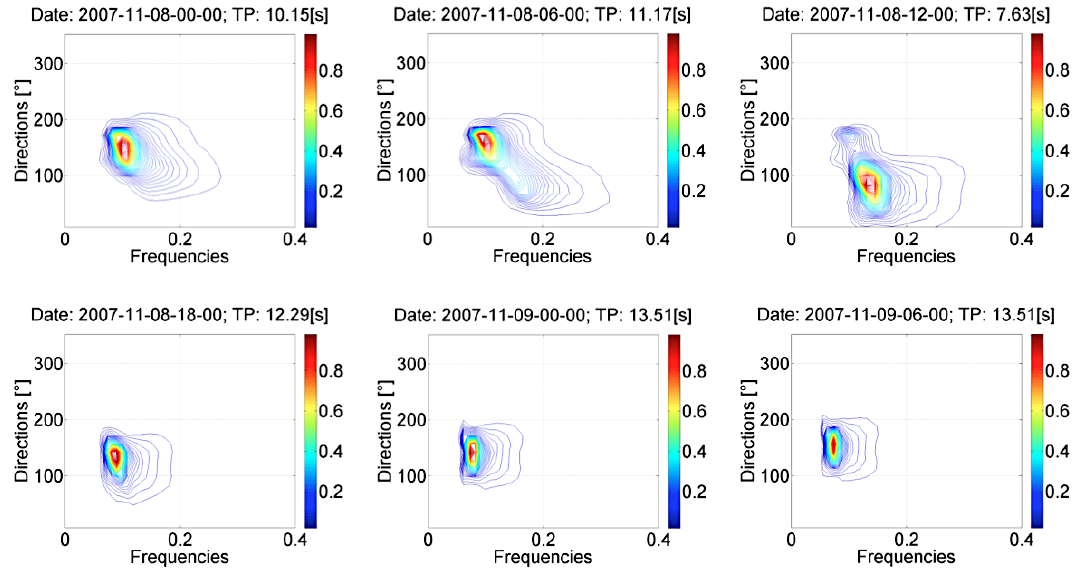
Figure 4. Evolution of the directional wave spectrum during the Andrea storm, from 00:00UTC 8 November 2007 to 06:00UTC 9 Novem- ber 2007.